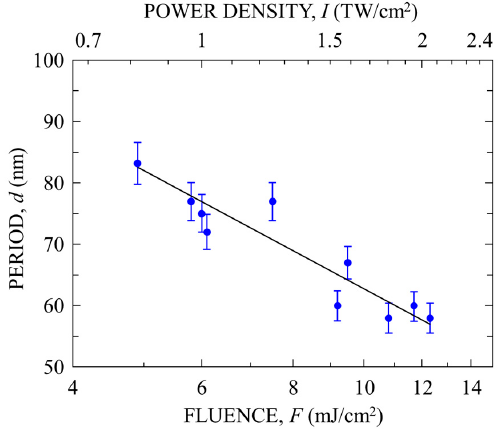
Figure 4. Period d of a periodic nanostructure (PNS) on DLC film formed with 7-fs laser pulses as a function of F and I for v = 0.1 μ m/s.